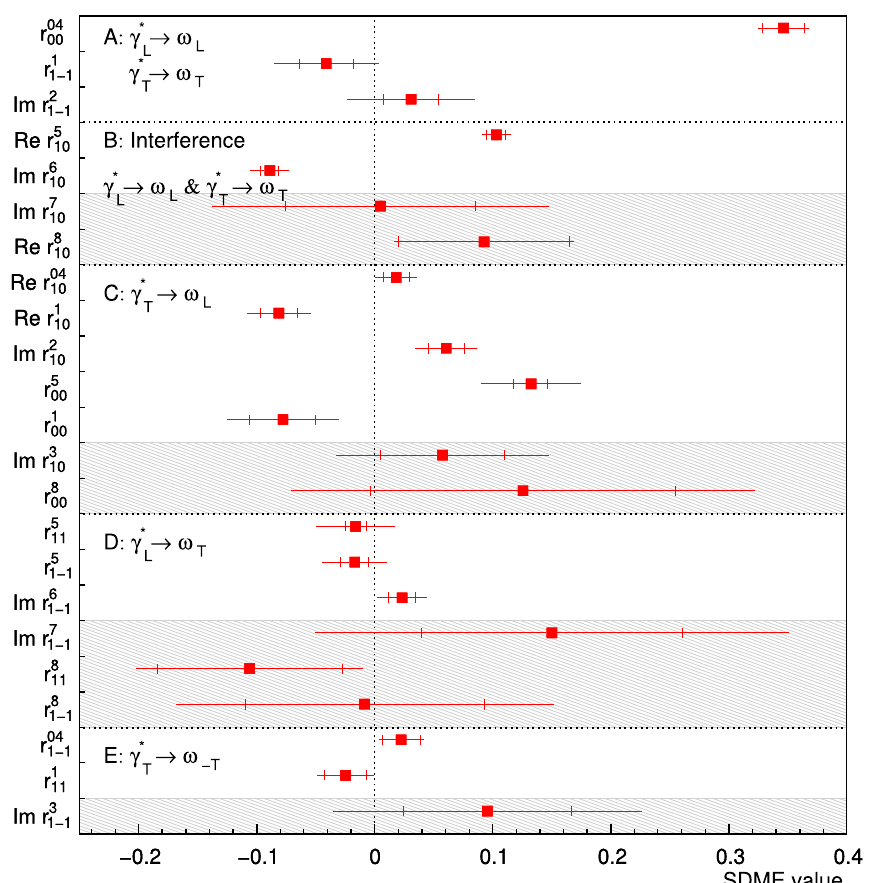
Fig. 5 The 23 SDMEs for exclusive ω leptoproduction extracted in the total COMPASS kinematic region with (cid:2) Q 2 (cid:3) = 2 . 13 (GeV/ c ) 2 , (cid:2) W (cid:3) = (cid:3) = 0 . 16 (GeV/ c ) 2 . Inner error bars represent statistical uncertainties and outer ones statistical and systematic uncertainties added 7 . 6 GeV/ c 2 , (cid:2) p 2 T in quadrature. Unpolarised (polarised) SDMEs are displayed in unshaded (shaded)